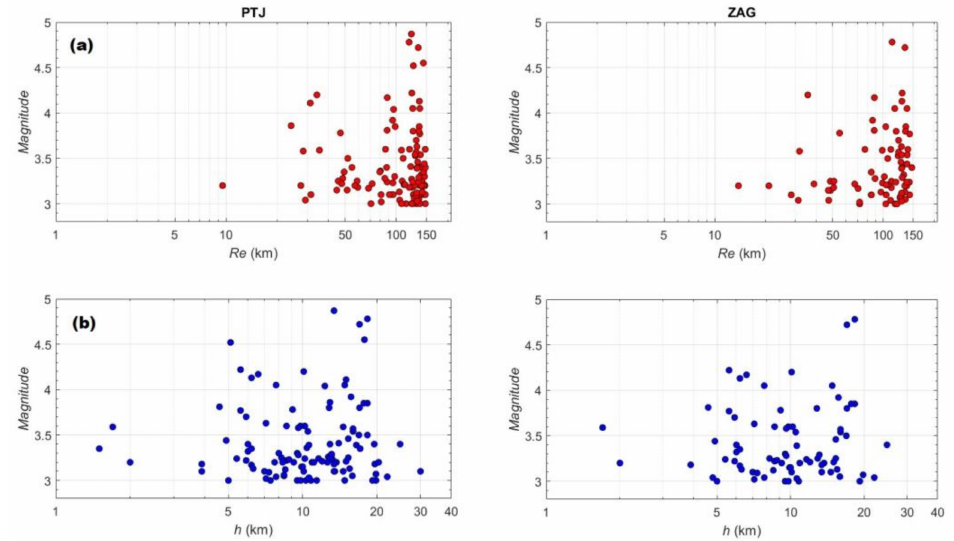
Figure 3. Statistics of the compiled ground motion dataset. ( a ) R e -M L distribution of recordings at PTJ and ZAG stations. ( b ) h-M L distribution of recordings at PTJ and ZAG